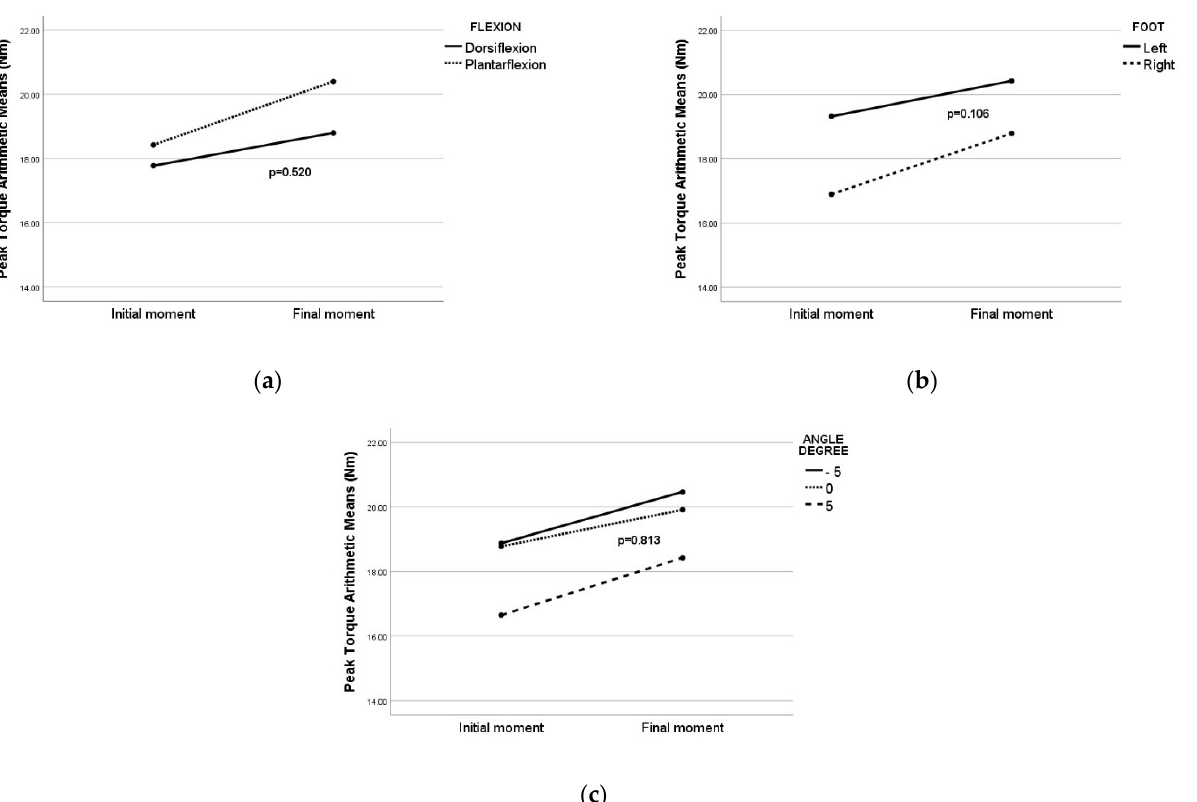
Figure 9. Arithmetic means of peak torque in group 1 with COVID-19: ( a ) arithmetic means of peak torque between flexion, p -value for flexion factor in multivariate analysis; ( b ) arithmetic means of peak torque between foot, p -value for foot factor in multivariate analysis; ( c ) arithmetic means of peak torque between angle, p -value for angle factor in multivariate analysis.